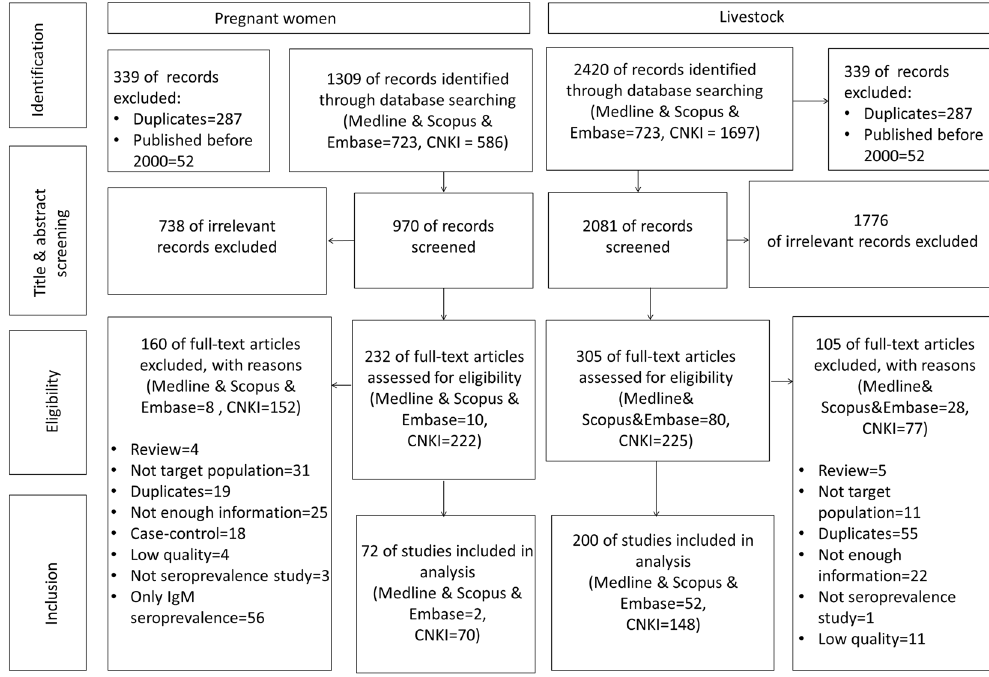
Figure 1. Flowchart: search strategy steps and selection of relevant studies on T. gondii seroprevalence in pregnant women and livestock in mainland of China. Five steps were included to select relevant studies for pregnant women and livestock in mainland of China.